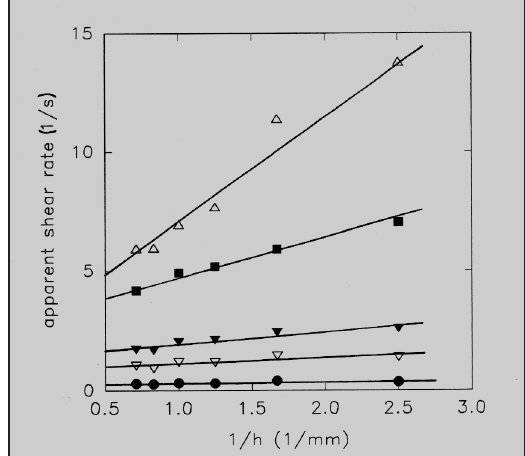
Figure 4 (left): The apparent shear rate as a function of the inverse of the rheometer gap for a 1% w/w hydrophobically modified (hydroxypropyl) guar aqueous solution at five imposed shear stresses: